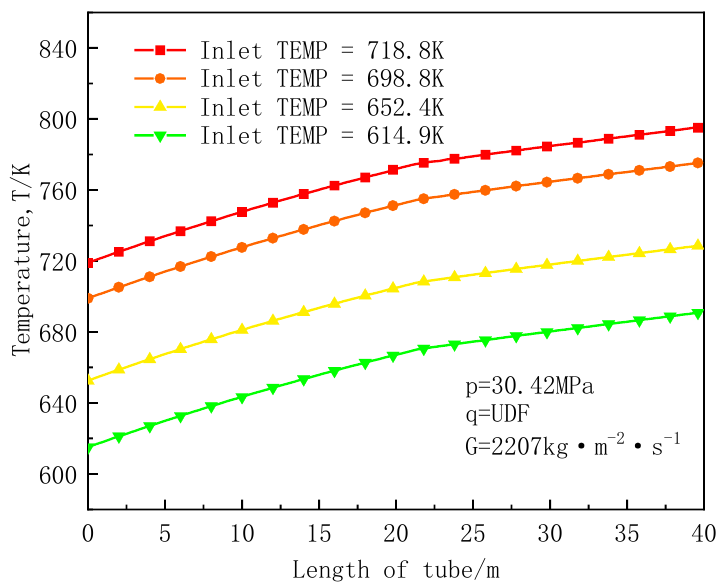
Figure 14. Temperature distribution of the tube length at different inlet temperatures ( p = 30.42 MPa, G = 2207 kg/(m 2 · s), T = 614.9~718.8 K).